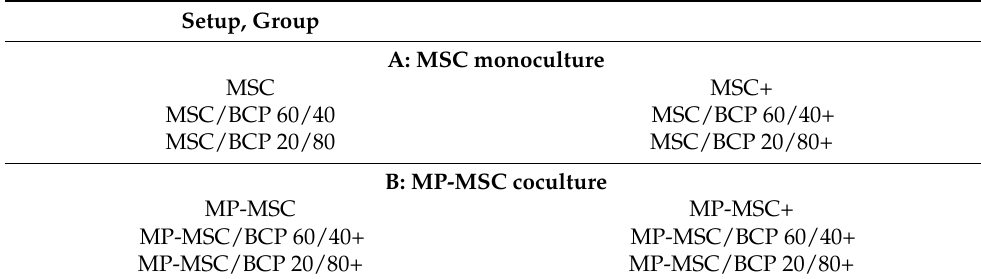
Table 1. Summary of experimental setups and groups. Setup, Group